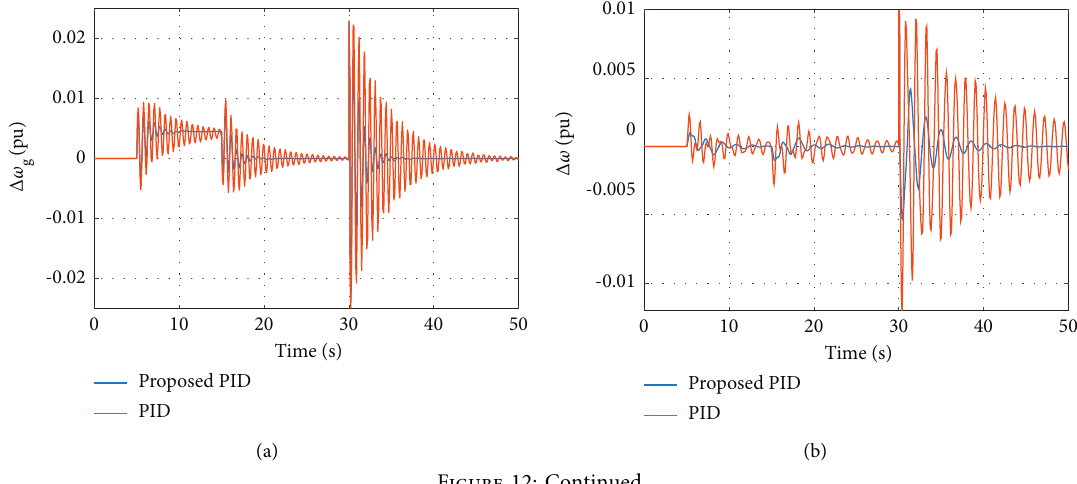
Figure 11: (a) The rotor speed deviation in WPP ( V displacement of rotor in WPP ( V w ≈ 14m/s). (d) The load angle deviation in CPP ( V w ≈ 14m/s). (e) The common terminal voltage ( V w ≈ 14